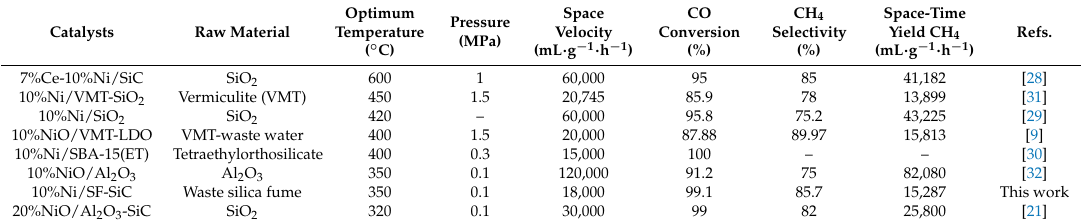
Table 1. The comparison of catalytic performance in different works.